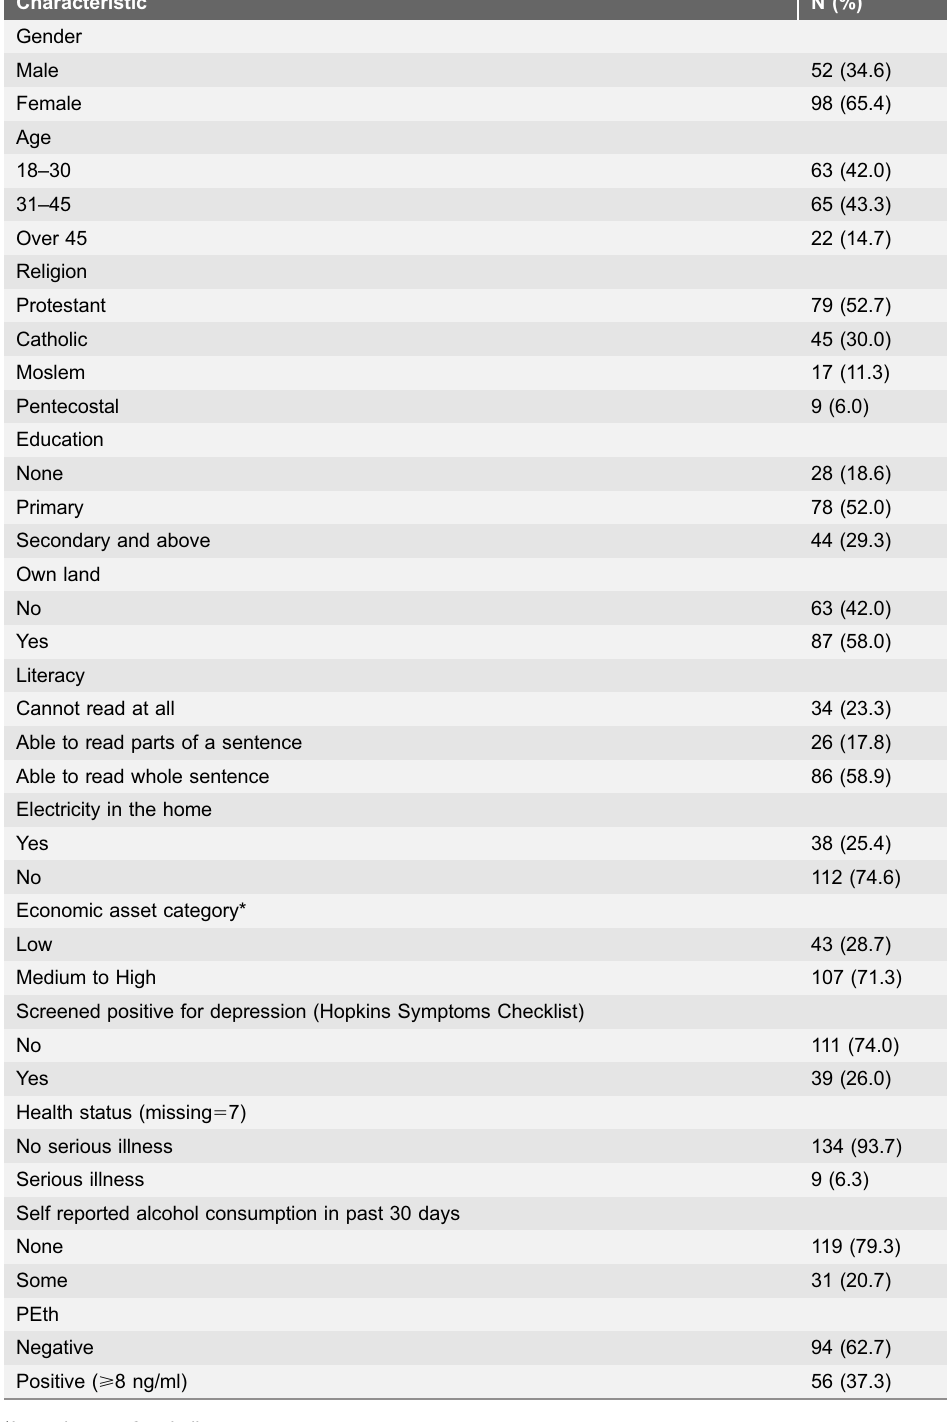
Table 1. Baseline characteristics (n 5